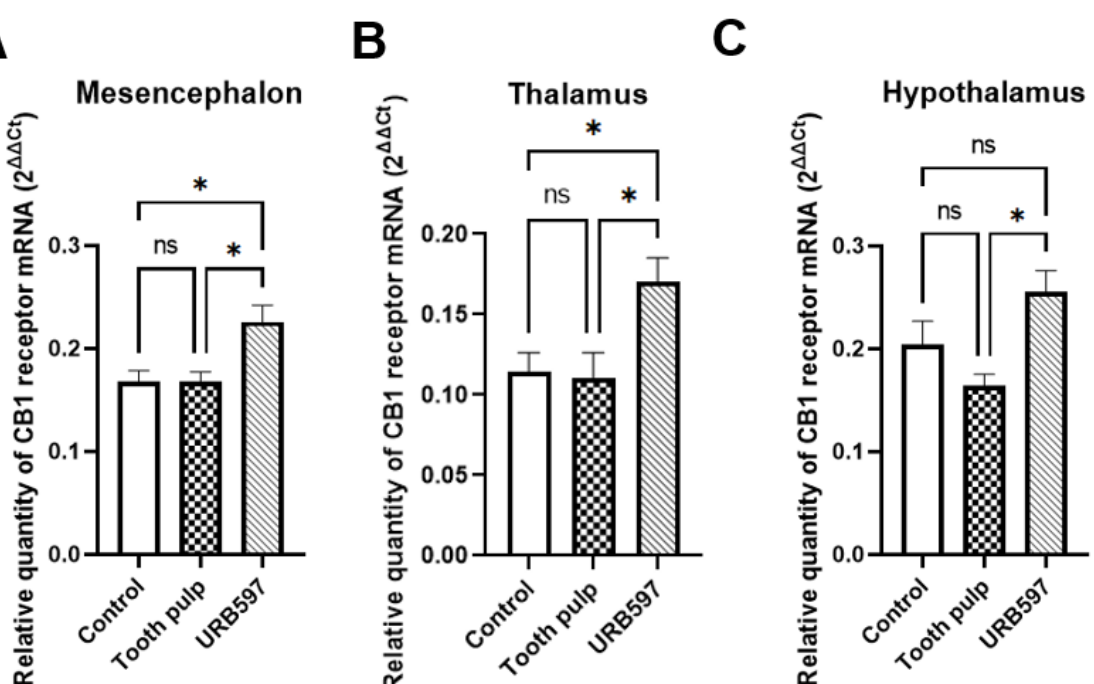
Figure 5. Quantitative RT-PCR analysis of CB1 receptor mRNA expression in ( A ) mesencephalon, ( B ) thalamus and ( C ) hypothalamus induced by tooth pulp and URB597 treatment. The data represent mean ± SEM of 6 rats per group. Statistical significance was assessed using one-way ANOVA and a post hoc multiple comparison Tukey test. Asterisks denote significance level (* p < 0.05, ns—not statistically significant).